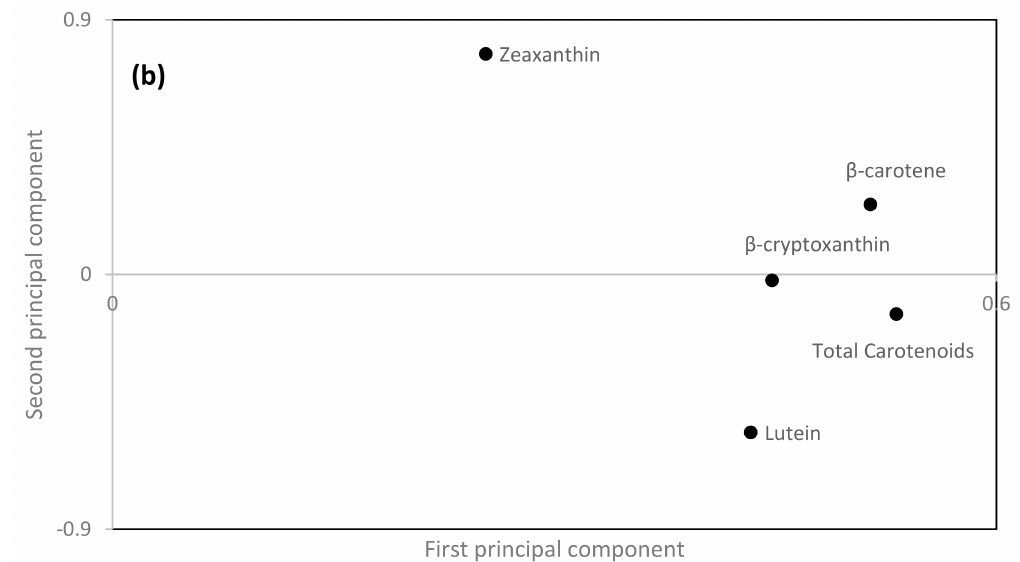
Figure 1. Loading ( a ) and score ( b ) plot from principal component analysis of carotenoid compounds and total carotenoid content in organically grown locally adapted spring cereals. First principal component explained 61.3% of the variation while the second principal component explained 23.7% of the